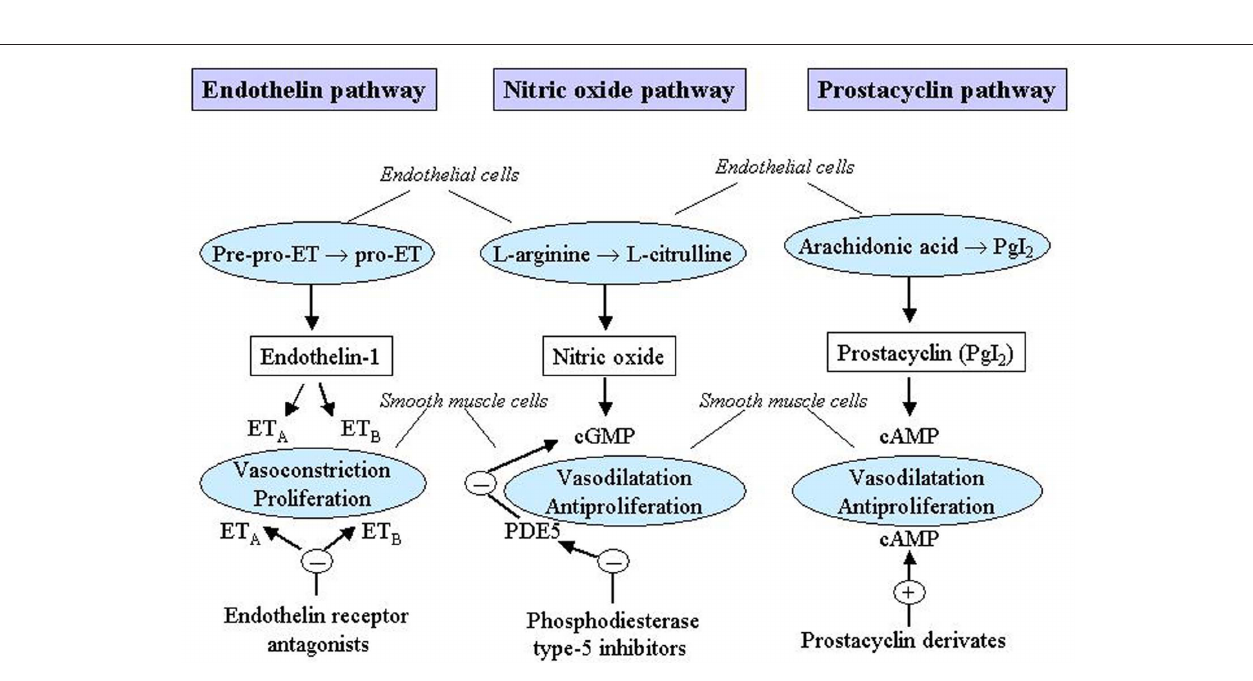
, endothelin receptor B; PDE5, phosphodiesterase endothelin receptor A; ET B type-5; PgI , prostaglandin I . Reproduced with permission from Humbert et al. 2 2 , (2004a) and Boutet et A